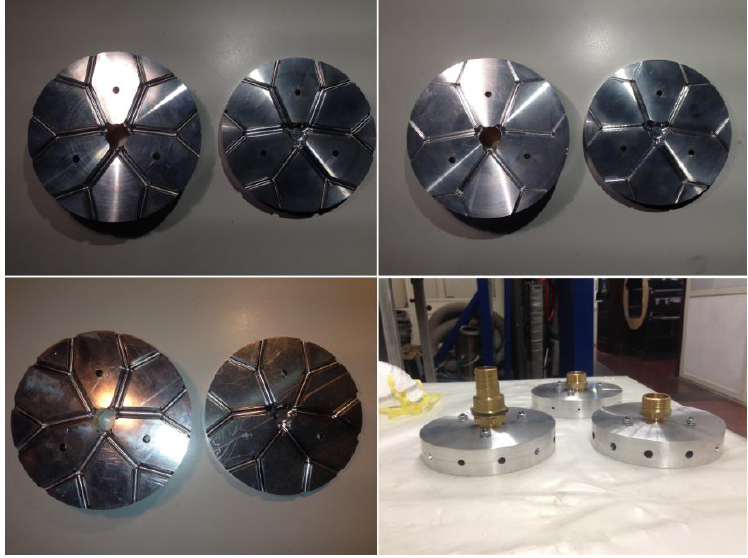
Figure 7. The DSHE-C1 described in Ref. [10,12].